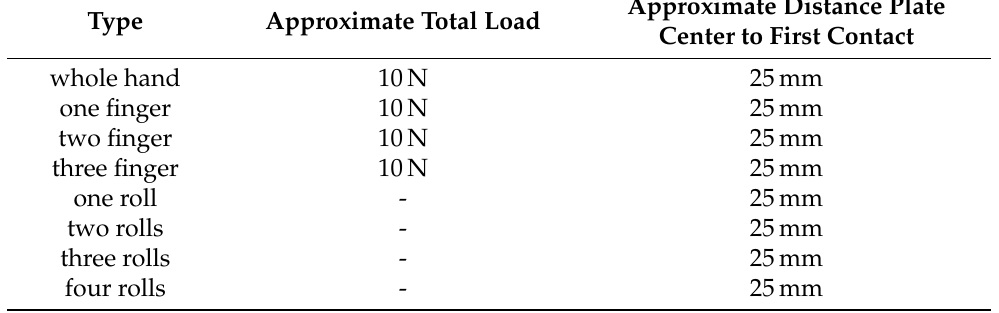
Table 3. Artificial environmental disturbances of EMI measurements.